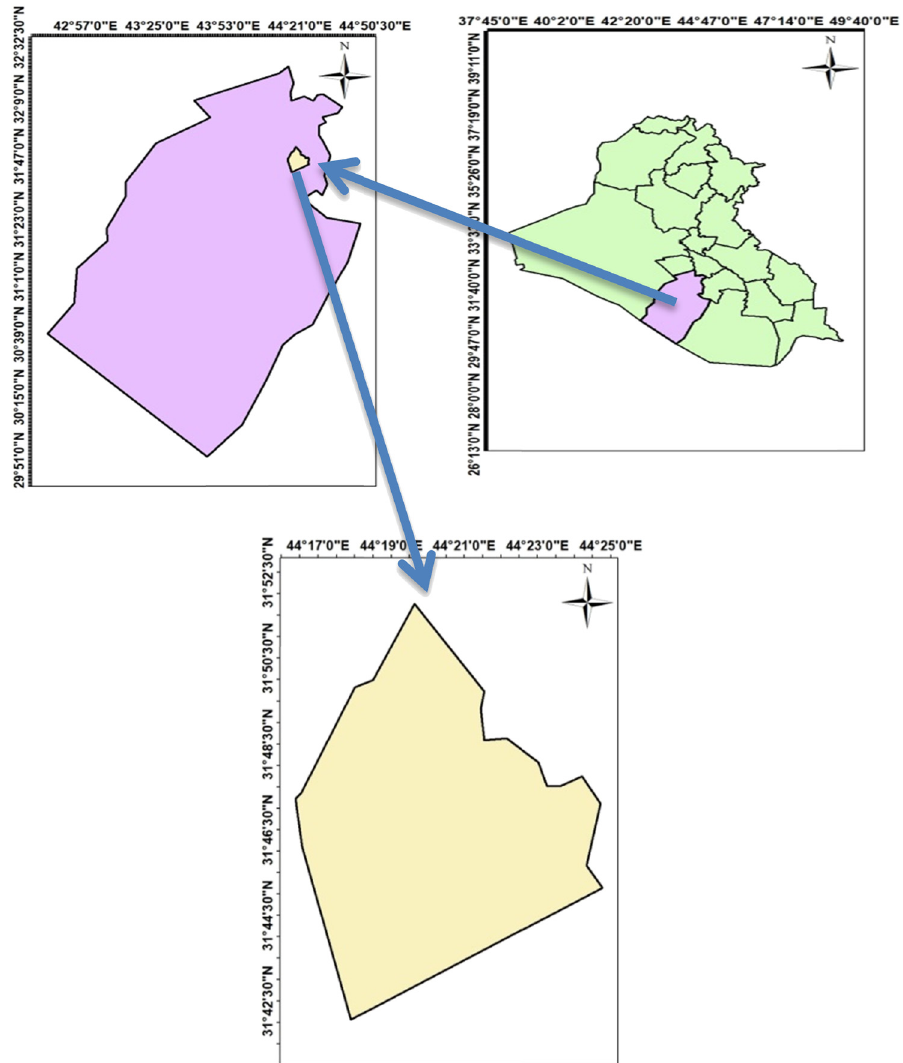
Figure 1: Location of Al - Ruhbah region in Al Najaf